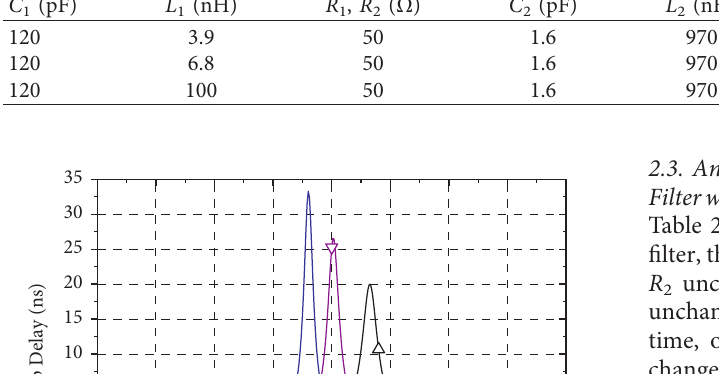
Table 4: Element values and performance indexes of band-stop filter with different L C 1 (pF)